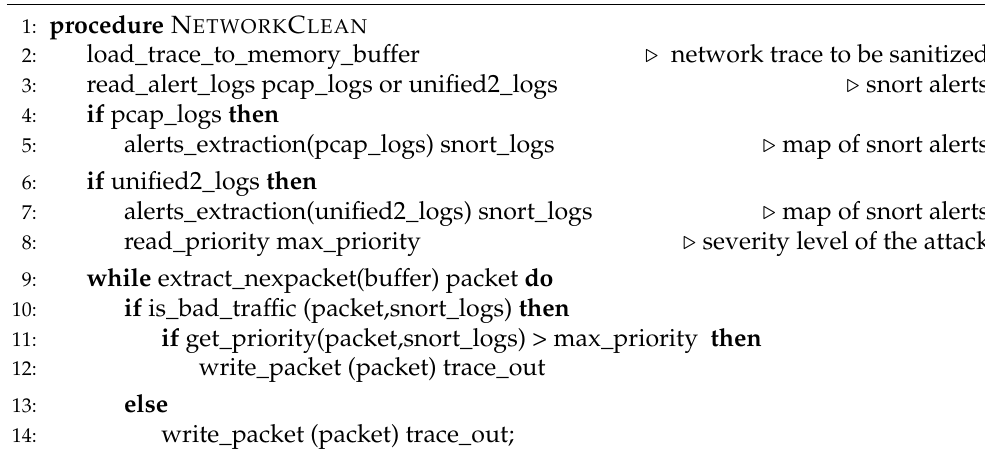
Algorithm 1 Raw network dumps cleansing.